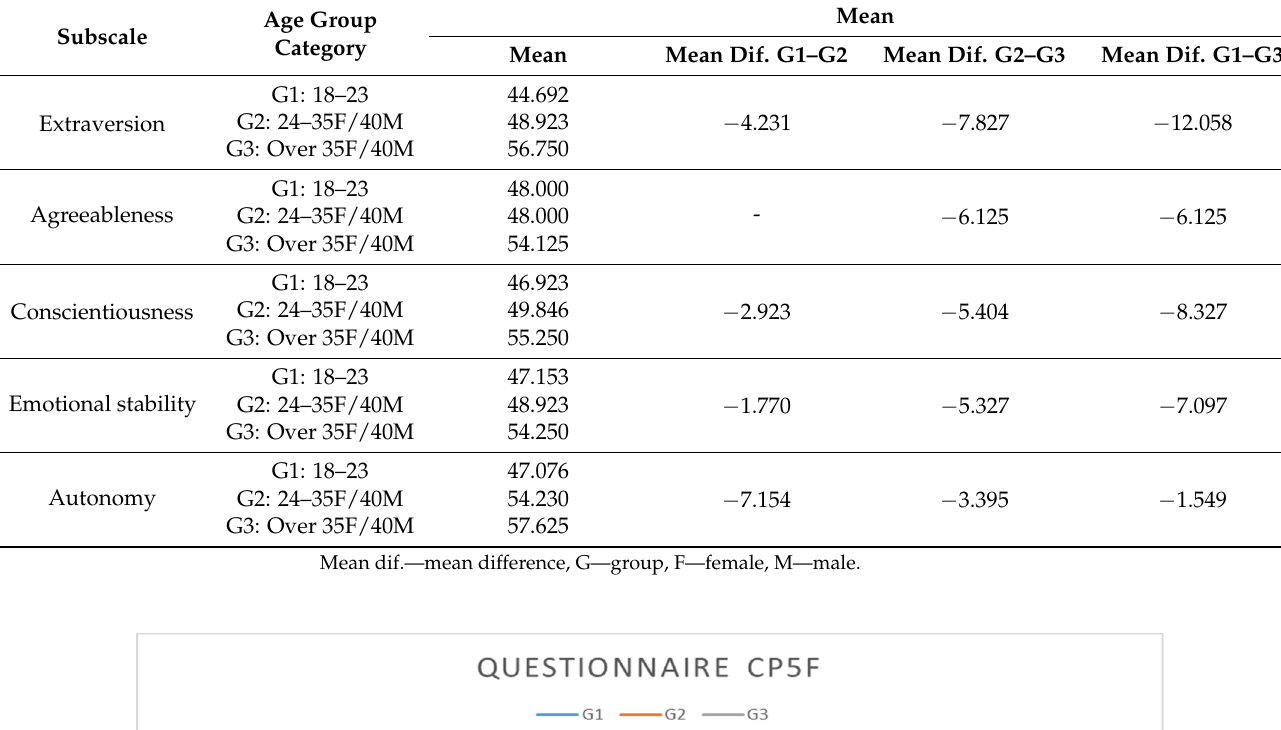
Table 3. Mean differences between groups for the Five-Factor Personality Questionnaire (CP5F) subscales.